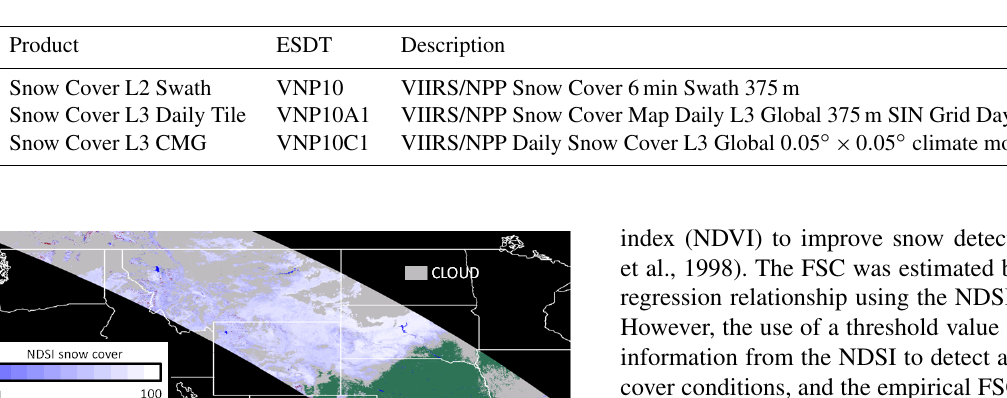
Table 2. Summary of land snow-cover products produced at the Land Science Investigator-led Processing System (LSIPS) described at https://earthdata.nasa.gov/about/sips/sips-snpp-land.